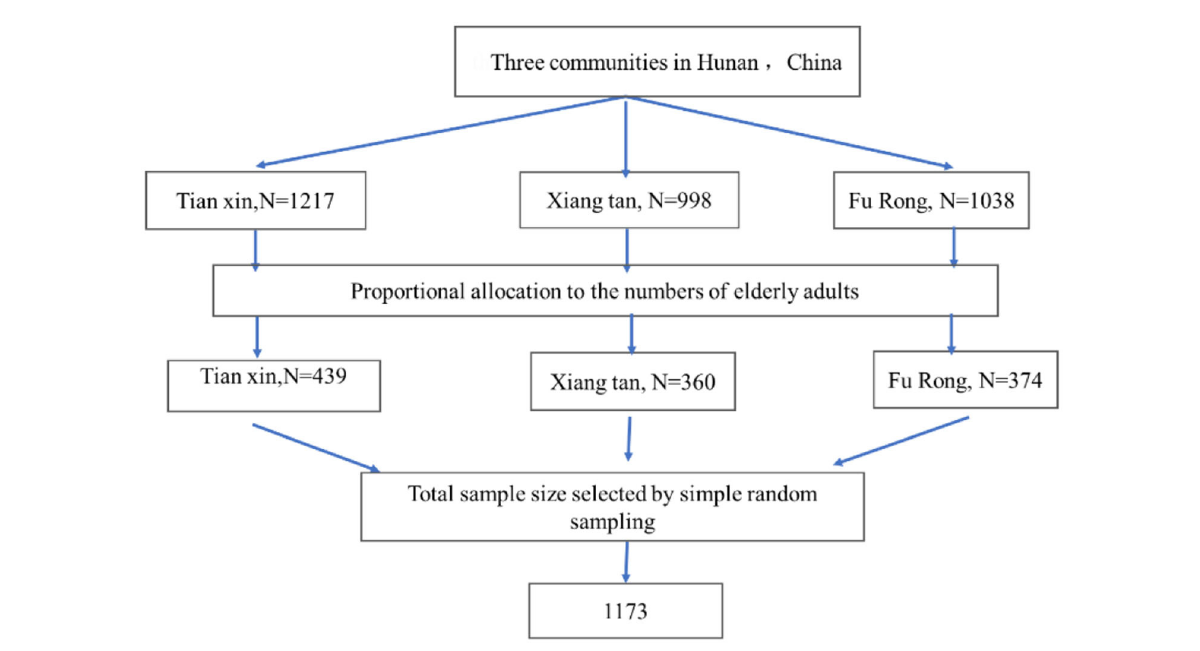
FIGURE1 The flowchart of this